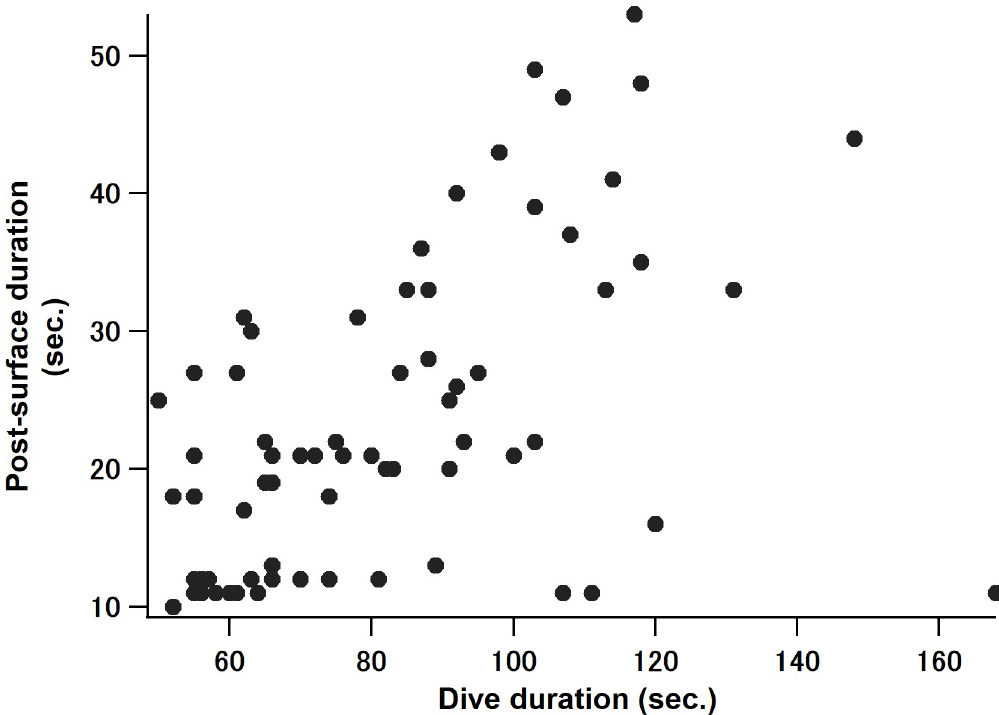
Fig 4. Relationship between dive duration and post-surface duration of foraging dives with greater than or equaled to two lunges within 35 m in depth. This showed positive relationship (Spearman’s ρ = 0.54, P < 0.0001; n = 70).